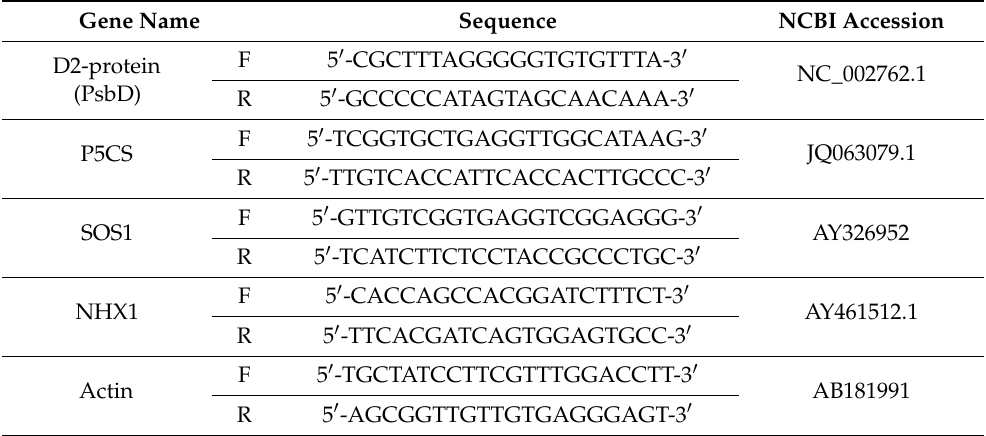
Table 1. Oligonucleotides primer pairs used for quantitative RT-PCR